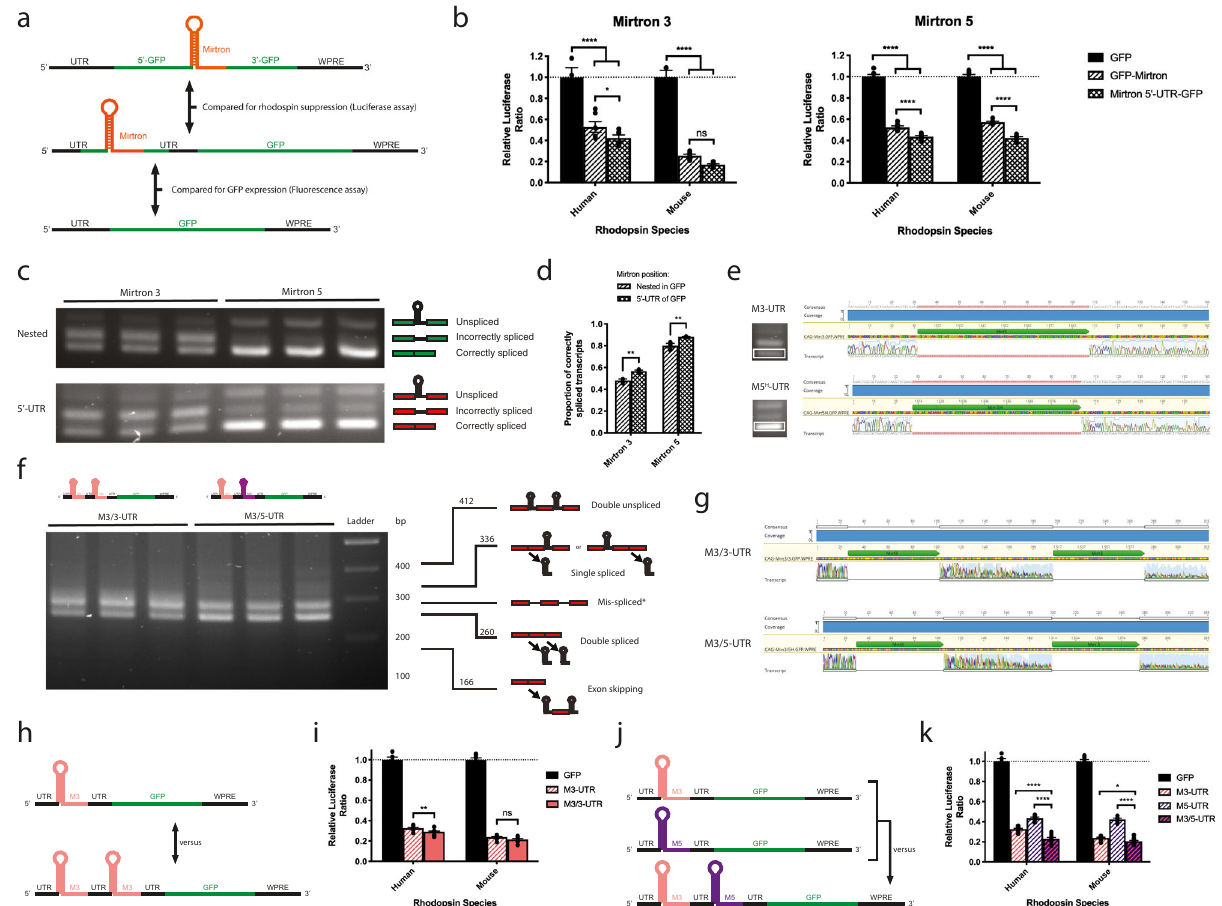
Fig. 2 Splicing and potency of mirtrons located in the 5 ′ -UTR of the eGFP transgene. a Experimental scheme for comparison of nested and 5 ′ -UTR mirtrons in HEK293 cells. b Rhodopsin knockdown compared for 5 ′ -UTR mirtrons and nested equivalents. Data shown for M5 version directed against its corresponding rhodopsin species ( n = 6). ns p = 0.118, * p = 0.046, **** p < 0.0001. c PCR products generated using mirtron-spanning primers and template cDNA derived from cells transfected with nested or 5 ′ -UTR versions of mirtrons ( n = 3). d Band densitometry revealed a greater proportion of correctly spliced transcripts for mirtrons located in the 5 ′ -UTR ( n = 3). Mirtron 3: p = 0.0048; Mirtron 5: p = 0.0066. e Sanger sequencing of the smallest bands (highlighted in white boxes) con fi rms accurate splicing of mirtrons from the 5 ′ -UTR. Alignment of amplicon electropherograms with their corresponding reference sequences con fi rms absence of the 76 bp mirtron. f PCR splice analysis of tandem mirtrons ( n = 3). Schematics illustrate predicted band sizes of splice products. *Band may represent a mixture of products. g Sequencing of the smallest bands in ( f ) con fi rms accurate splicing of tandem mirtrons. h Experimental scheme for comparison of M3-UTR and M3/3-UTR constructs. i Dual Glo ® assay comparing M3-UTR and M3/3-UTR ( n = 12). ns p = 0.0583, ** p = 0.0031. j Experimental scheme for comparison of M3-UTR, M5-UTR and M3/5-UTR constructs. k Dual Glo ® assay comparing M3-UTR ( n = 12), M5-UTR ( n = 6) and M3/3-UTR ( n = 12). * p = 0.0192, **** p < 0.0001. Data for each version of M5-UTR and M3/5-UTR directed against its corresponding rhodopsin species are shown. M3/5 M -UTR did not provide additional knockdown of human RHO beyond that of M3-UTR. Similarly, no difference in mouse Rho suppression was detected between M3/5 H -UTR and M3-UTR. Mean± SEM plotted throughout. Two-sided Š idák ’ s multiple comparisons tests used in all